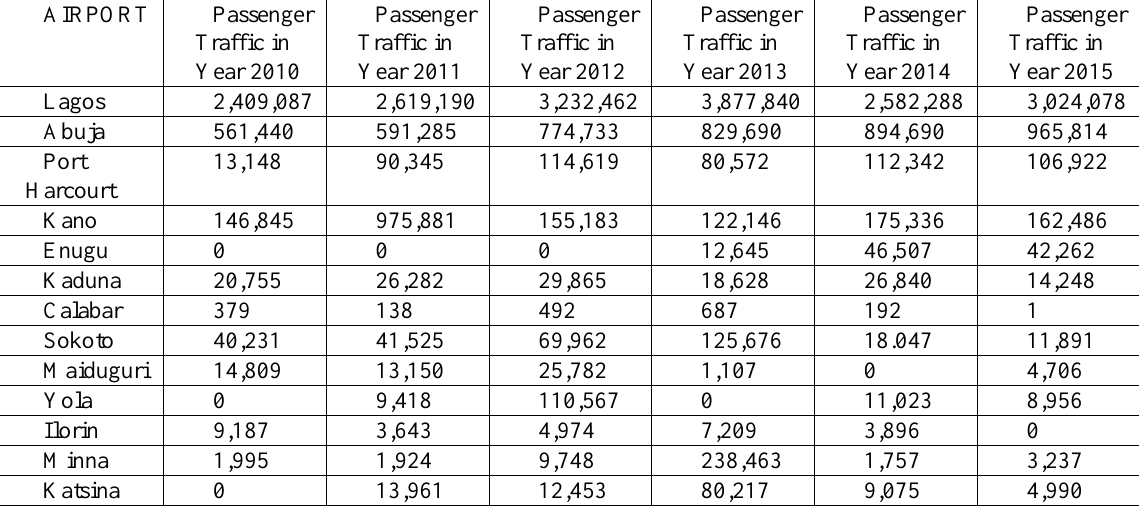
Table 6. International air passenger traffic in each airport in Nigeria between year 2010 and year